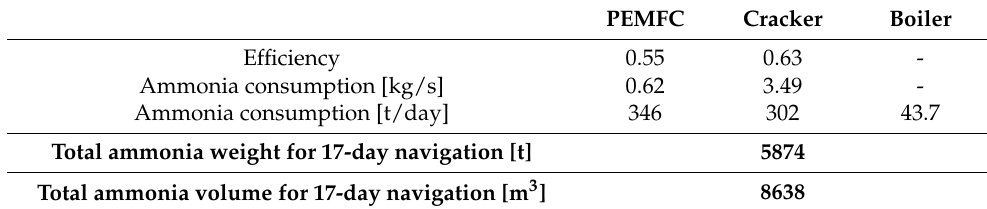
Table 9. Consumption calculations for hydrogen-fueled PEMFCs.